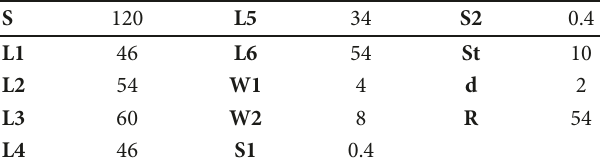
Table 1: Details of antenna parameters (all dimensions are in mm).